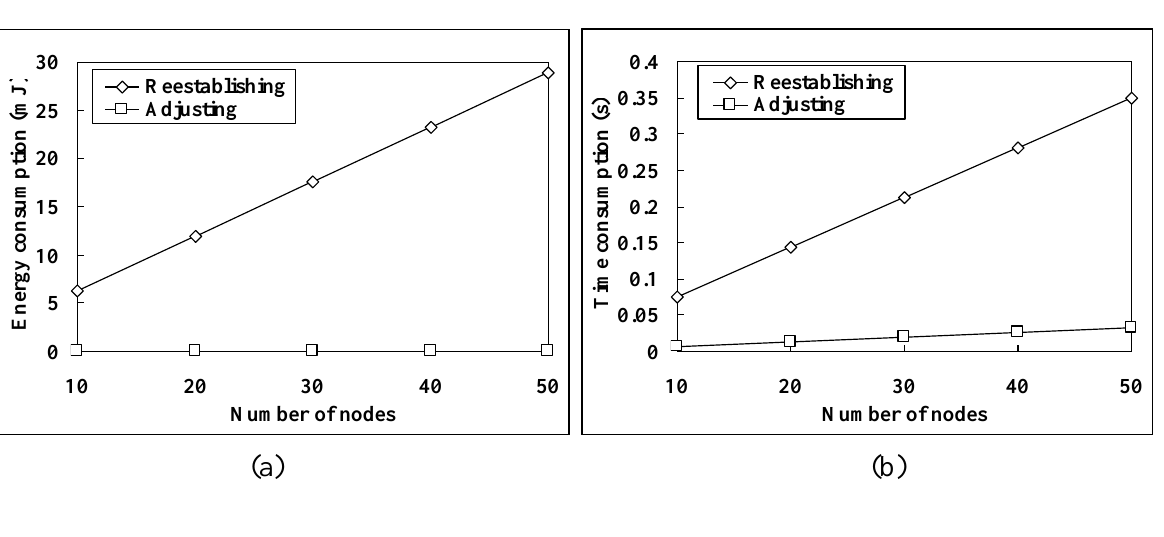
Figure 11. Comparison between the schedule reestablishment and adjustment: (a) energy consumption and (b) time